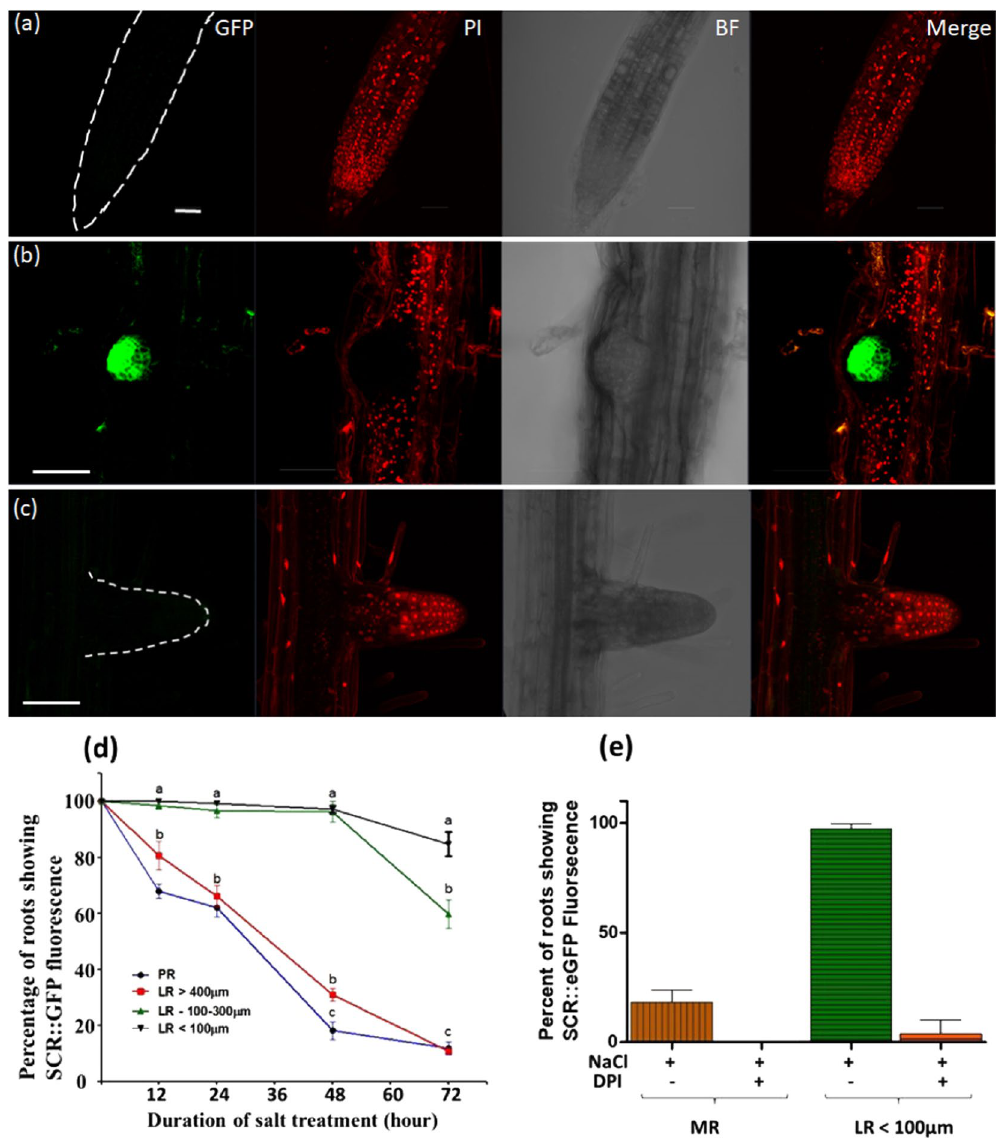
Figure 2. SCR::GFP fluorescence in the PR and the LR during lethal salinity. Seven day old SCR::GFP Arabidopsis seedlings were subjected to salt stress (200 mM NaCl + 1/2 MS) for 12, 24, 48 and 72 h and then stained with PI as in Fig. 1. Shown are representative confocal images of: ( a , b ) SCR::GFP plants during salt stress with ( c ) or without DPI. The confocal images were captured after 48 hours of stress. The GFP and PI fluorescent signals were captured as mentioned in methods. Scale bars = 50 µ m. ( d ) Is graphical display of the GFP signal in ( a – c ) during 0,12, 24, 48 and 72 hours of salt stress. ( e ) Histogram of SCR::GFP fluorescence of the DPI treatment during 48 hours of salt stress. The experiments were repeated three times (n = 20 plants in each time point in all the experiment ± S.E.). Statistical analysis was done by Tukey’s Honest Significant Difference test (at P < 0.05) for each time point separately. (Significant differences are indicated by small letters). The shown images are projection of the entire z-stack at maximum intensity. The complete Z stack of the individual of the presented images can be found in Figs. SI4–SI6. Confocal images of non-stressed plants can be found in Fig.